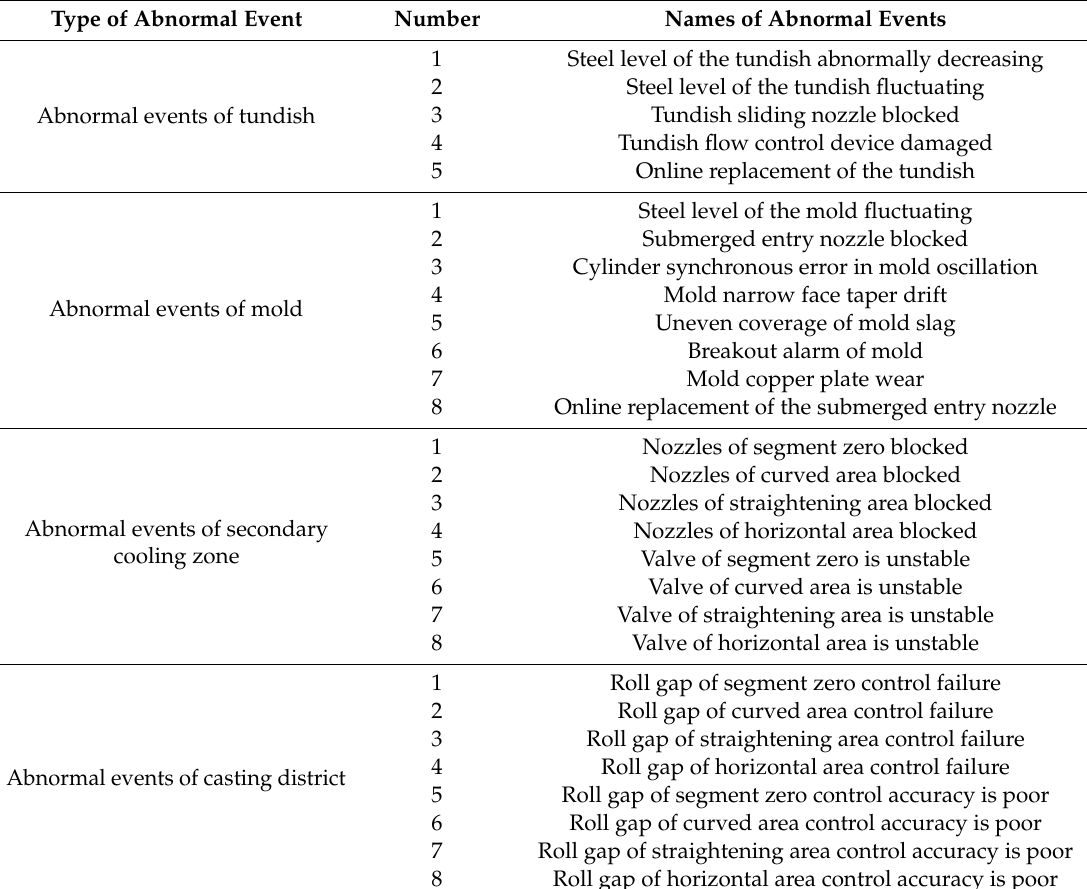
Table 3. Detailed list of the classification of casting abnormal